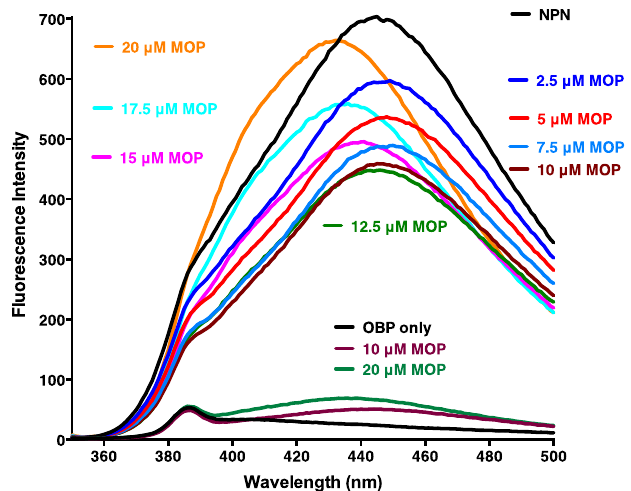
Figure 3. Binding of MOP to AaegOBP1. Following addition of NPN, fluorescence emission spectra were recorded with increasing doses of MOP. Note the decrease in fluorescence intensity (quenching) as the doses increases up to 10 µM and an increase in fluorescence and blue shift at higher doses. In a separate experiment, included in the lower part of the figure for comparison, fluorescence emission spectra were recorded with AgamOBP1 alone and after addition of MOP, but in the absence of NPN.